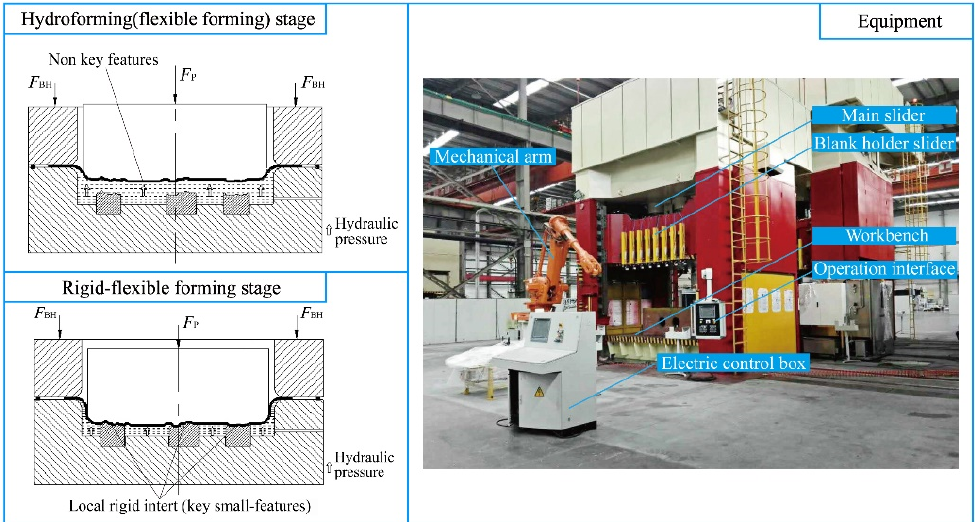
Figure 3. Principle of rigid-flexible sequential loading forming and equipment.